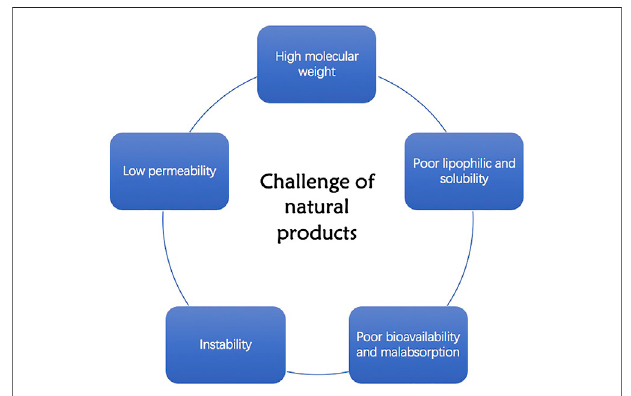
FIGURE 1 | Challenges of natural products.